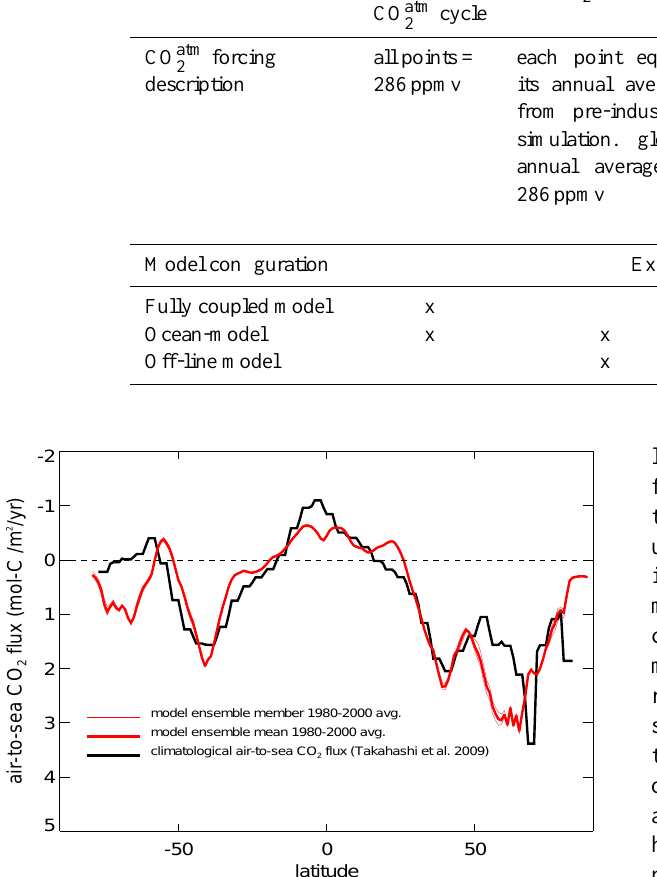
Fig. 2. Comparison of latitudinally averaged (above ocean) air- sea CO 2 fluxes calculated from an observation-derived climatology (Takahashi et al., 2009) (black), and from climate simulations us- ing the HadGEM2-ES model (red). Earth system model simulations were forced using greenhouse gas, anthropogenic aerosol, volcanic aerosol, land-use change and solar cycle data from the years 1860– 2005 (Taylor et al., 2009; Jones et al., 2011). The observation-based climatology has been calculated to represent the conditions in the year 2000, but to avoid sampling internal variability, the model re- sults have been presented as a mean value from the years 1980– 2000. The model’s ensemble mean has been calculated as the av- erage of three historical simulations started at 50yr intervals from the pre-industrial control simulation, and is therefore considered to sample well the model’s internal